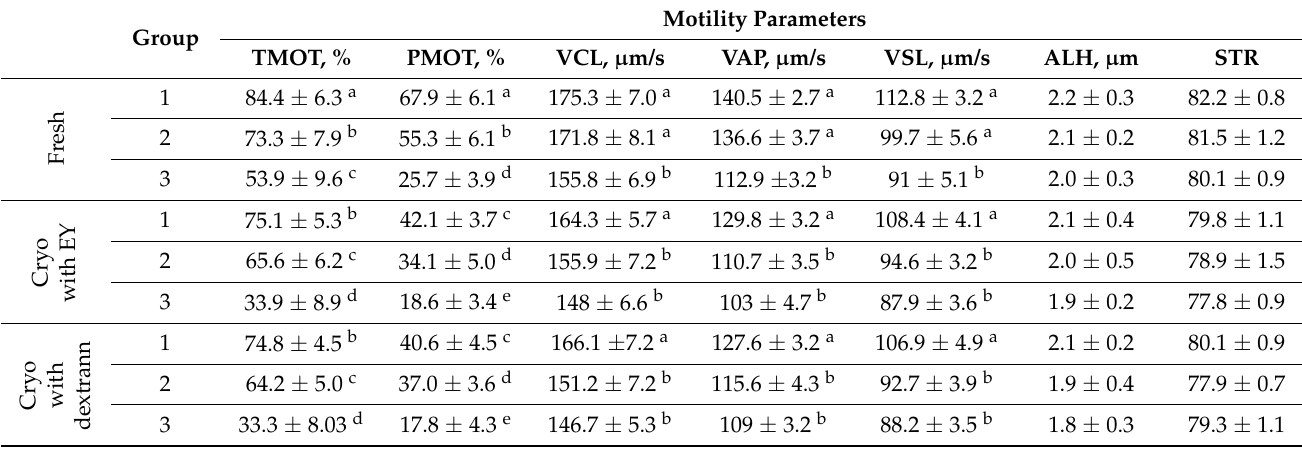
Table 3. Parameters of sperm motility measured by CASA .